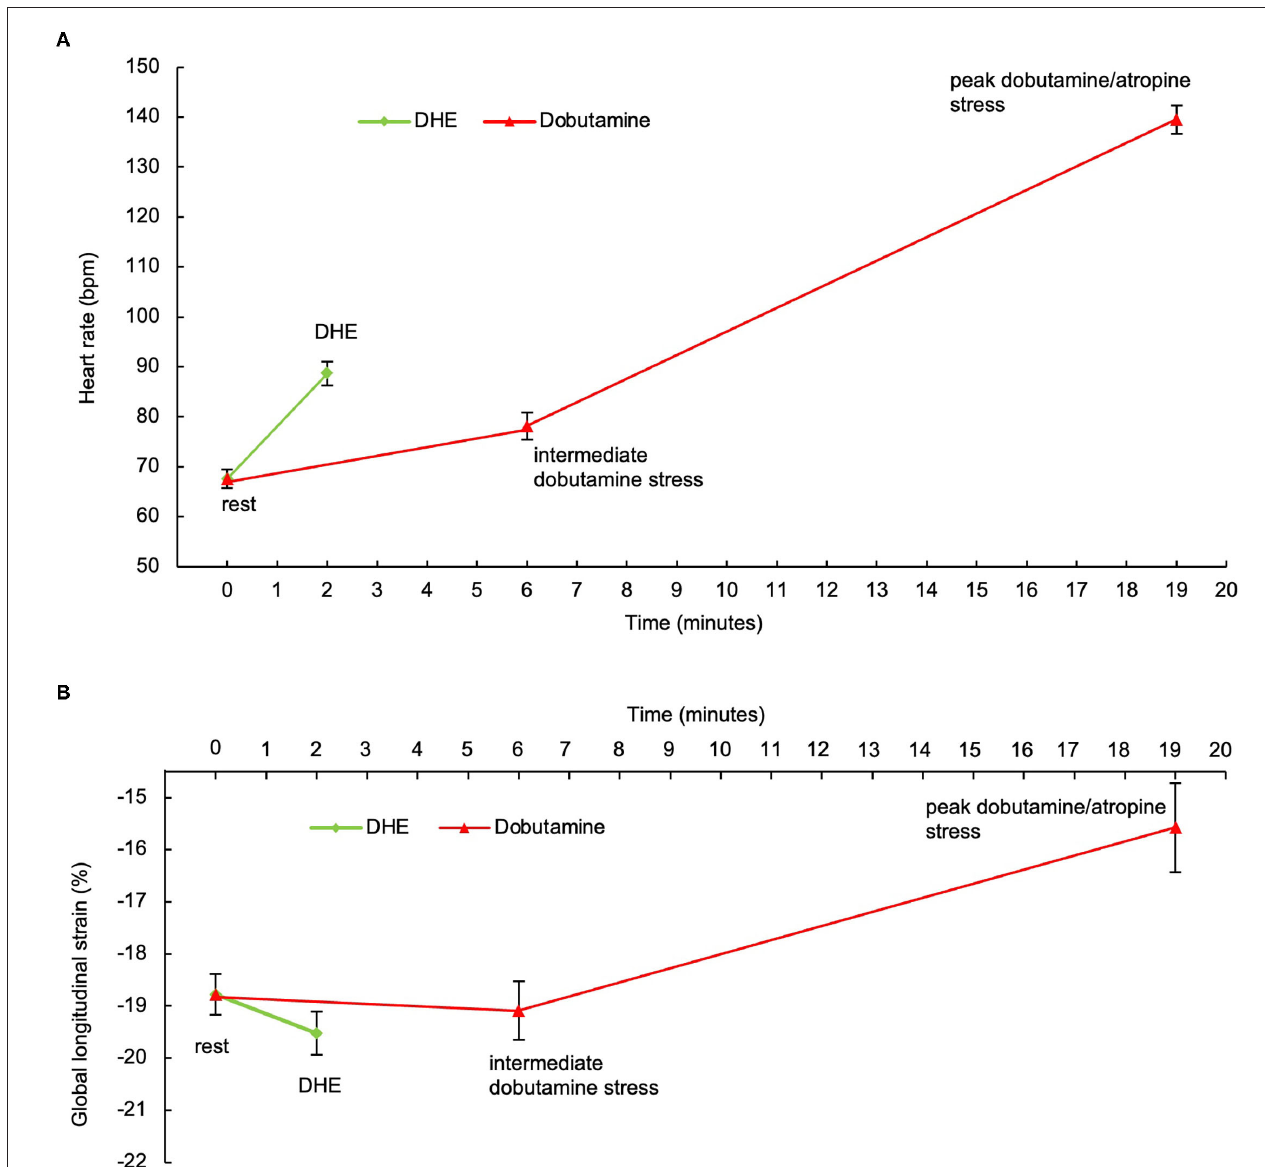
FIGURE 7 | (A) Heart response in group II after DHE (green) and during dobutamine stress (red). After 2min of DHE, HR significantly increased. HR DHE was significantly higher compared with HR during intermediate dobutamine stress. (B) GLS response in group II after DHE (green) and during dobutamine stress (red). GLS significantly increased after DHE. During dobutamine stress, GLS increased at intermediate stress level, before it decreased at maximum dobutamine/atropine stress. Error bars represent the standard error of the mean. HR, heart rate; DHE, dynamic handgrip exercise; GLS, global longitudinal